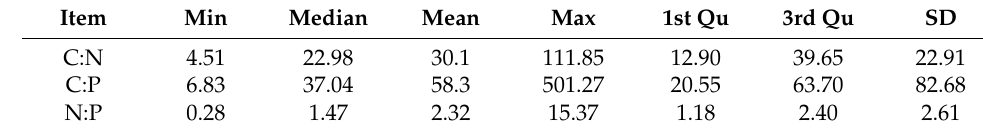
Table 5. Descriptive statistics of C:N, C:P and N:P ratios.